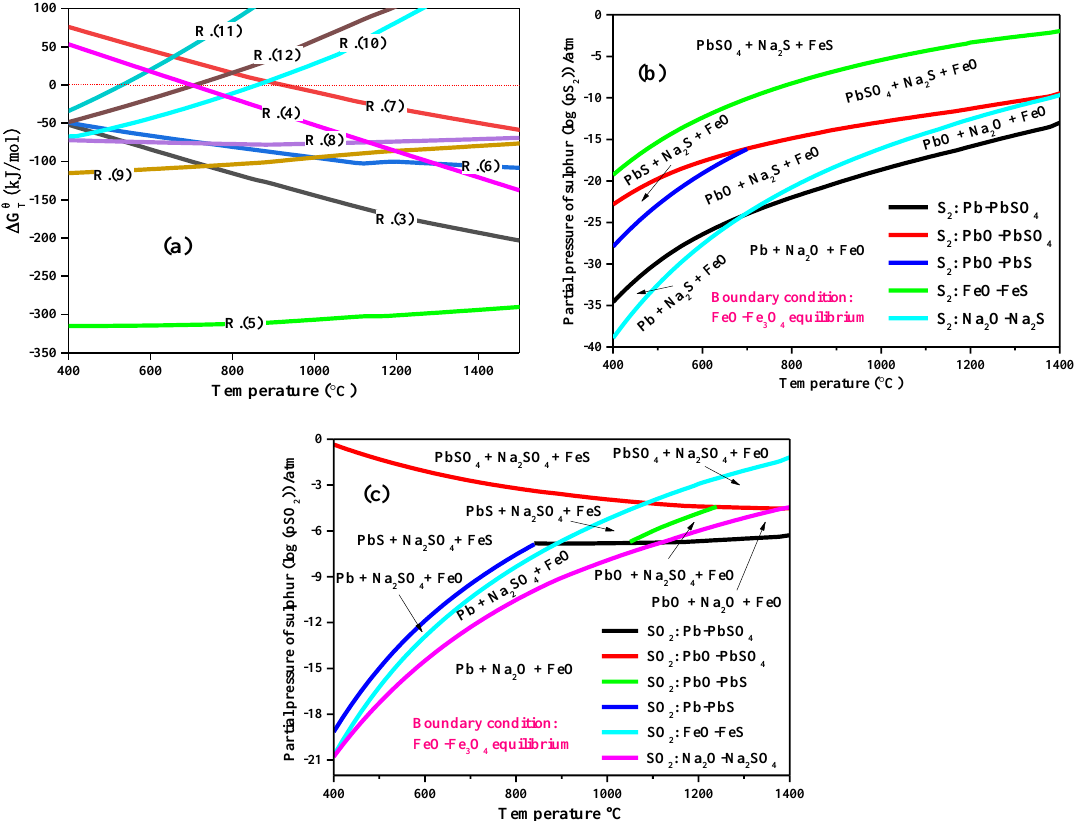
Figure 4. ( a ) The ∆ G θ and T diagram, ( b ) Log(pS 2 ) and T equilibrium diagram, and ( c ) Log(pSO 2 ) and T equilibrium diagram in the boundary condition of FeO-Fe 3 O 4 equilibria (data from HSC 9.2.6 database).